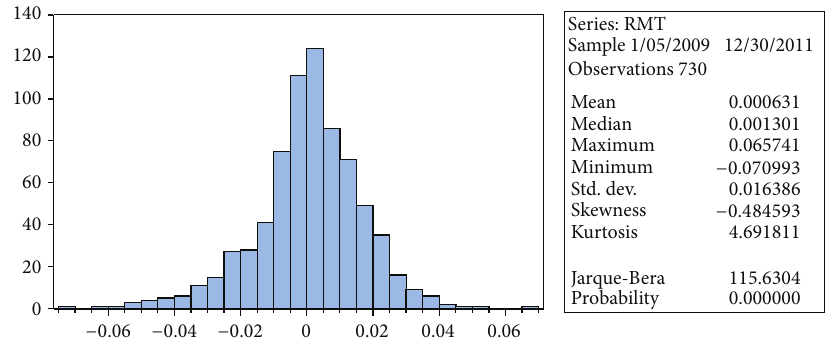
Figure 1: The histogram and statistics of 𝑅 𝑚,𝑡 .